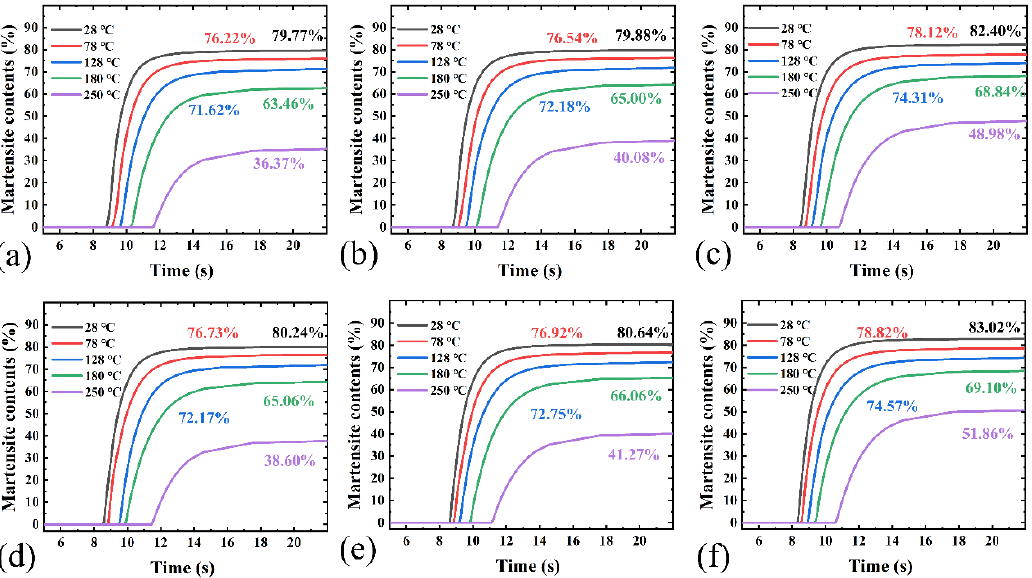
Figure 8. Simulated evolutions of martensitic contents at the feature points under different preheating temperatures. ( a ) Point A; ( b ) Point B; ( c ) Point C; ( d ) Point D; ( e ) Point E; ( f ) Point F.